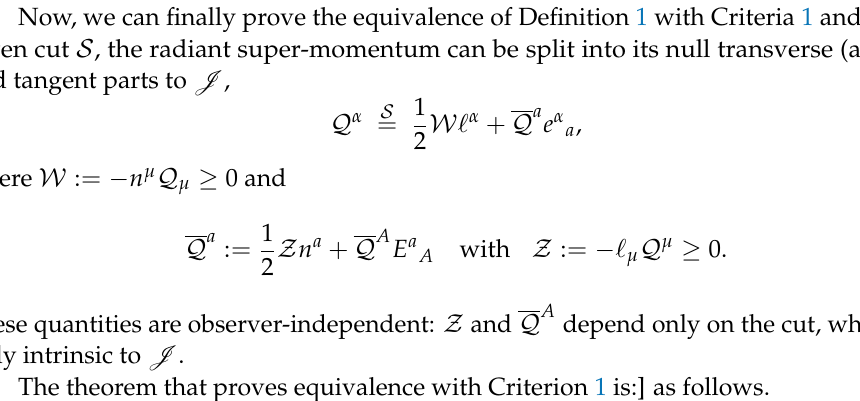
Figure 2. Schematic representation of a portion ∆ of J + delimited by two cuts S 1 and S 2 when Λ = 0 (one dimension is suppressed). The cut S topology as J + , and is depicted by the shadowed